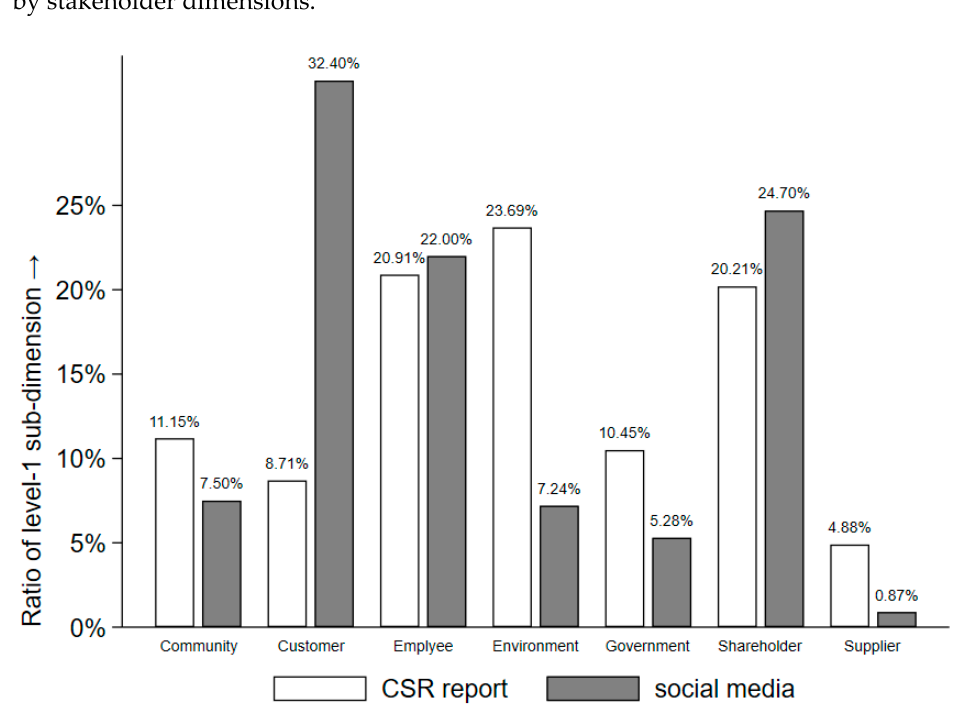
Figure 1. Comparison of CSR disclosure on social media and CSR reports.